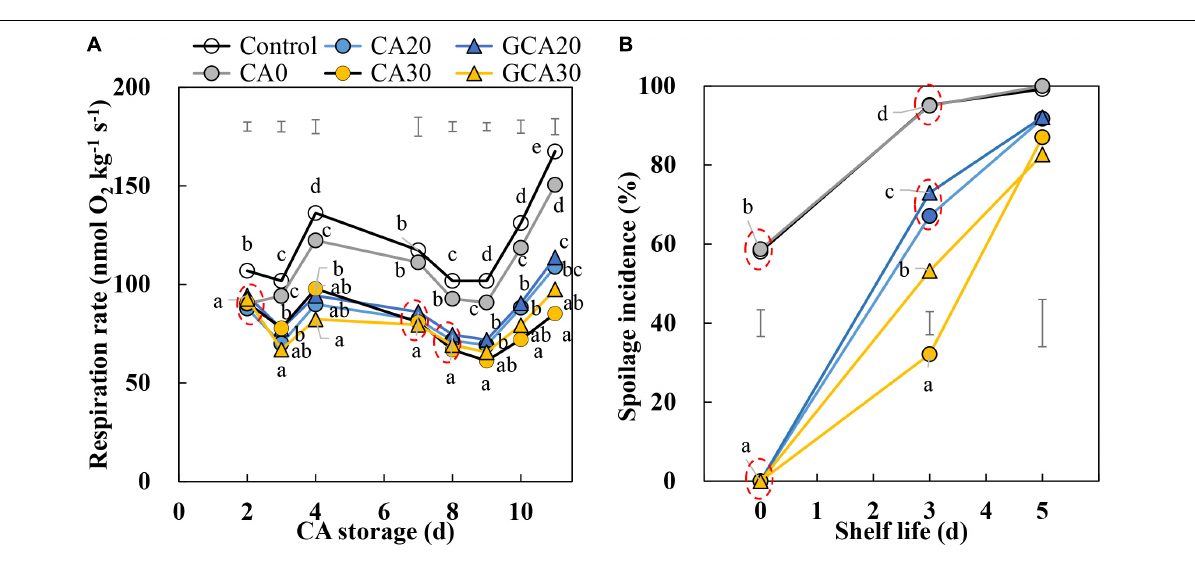
FIGURE 2 | Respiration rate and spoilage incidence of “Arabella” strawberry fruit during CA storage and shelf life. (A) Respiration rate during CA storage at 5 ◦ C and ∼ 100% relative humidity. (B) Spoilage incidence during shelf life at 12 ◦ C and ∼ 95% relative humidity in ambient atmosphere. As a control condition, 21 kPa O 2 and 0 kPa CO 2 were used. Data represent means of 2 blocks ( n = 2) with approximately 35 replicated fruit for respiration and approximately 25 replicated fruit for spoilage measurements per block. The error bars represent the standard error of means. Different letters denote significant differences according to Fisher’s protected LSD test ( α =